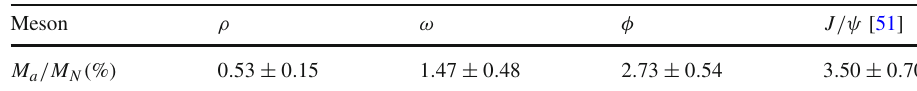
Table 6 The M a / M N extracted from the differential cross